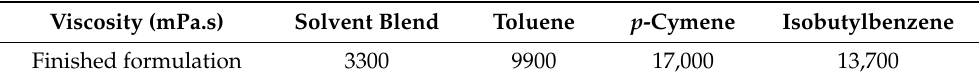
Table 3. Viscosity for solvent rubber mixture and finished formulations for the reference solvents and the replacement solvents.